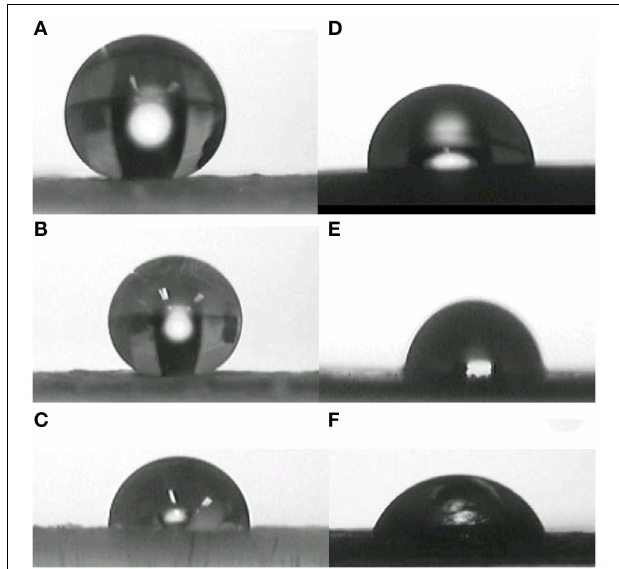
FIGURE 2 | Contact angles of water (A,D), glycerol (B,E) and diiomethane (C,F) on to blue gum (rough surface; A–C) and pepper fruit (smooth surface; D–F) surfaces, as an example.